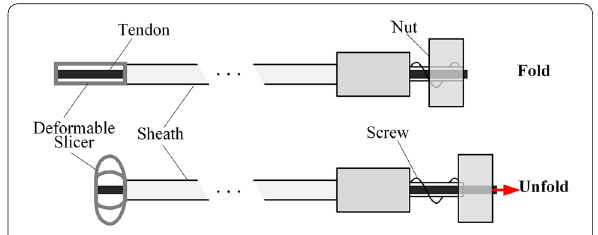
Figure 3 Design of instrument for scratching endometrium